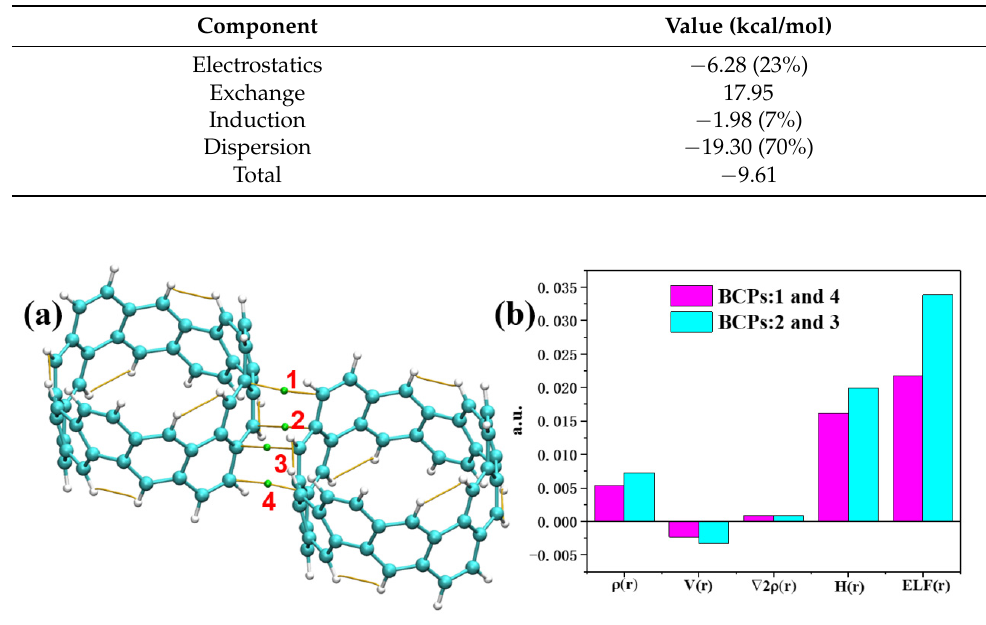
Figure 9. ( a ) BCPs (green ball) for intermolecular interactions. ( b ) The value of the real-space function at the BCPs.